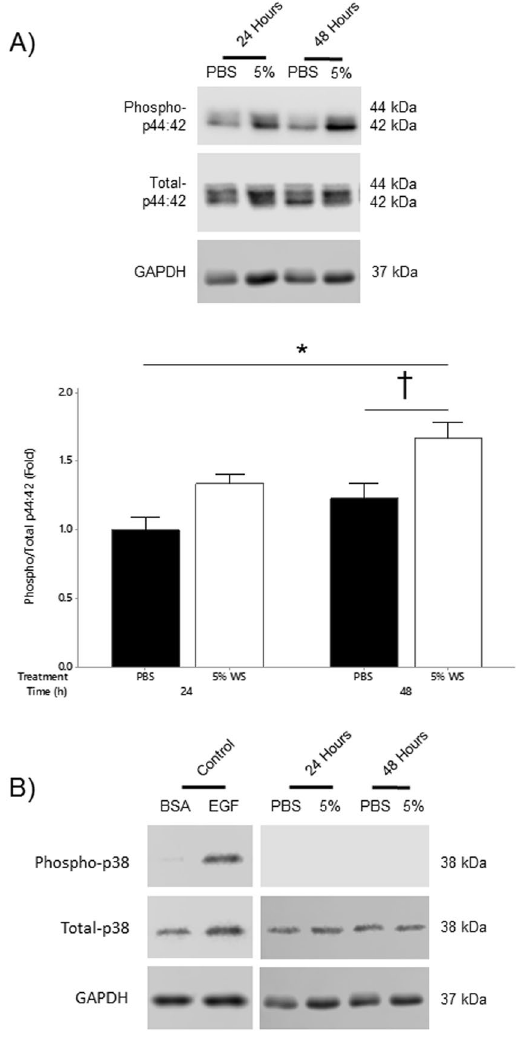
Figure 6. Activation of MAPK Signaling following Wood Smoke Exposure. ( A ) WS exposure resulted in activation of a p44/42 dependent MAPK signaling pathway. After 24 hours of WS exposure there was approximately a 50% increase in p44/42 phosphorylation although this was not significant. After 48 hours, there was a significant increase in p44/42 phosphorylation as compared to untreated cells after both 24 and 48 hours ( * P < 0 . 05 vs. 24 h Unt; † P < 0 . 05 vs. 48 h Unt; n = 4). ( B ) There was no evidence of p38 phosphorylation after 24 or 48 hours of exposure. EGF (10 ng/mL) stimulated cells were used as a positive control. BSA treated cells were used as a control for EGF stimulation. Images were cropped to show a representative image of each treatment and time point. All images were derived from the same blot following stripping and re-probing. Full blots are provided in Supplementary Figs S1, S2 and S3. Statistical differences were determined using a two-way ANOVA followed by a Tukey’s post-hoc test. Data presented as mean ±